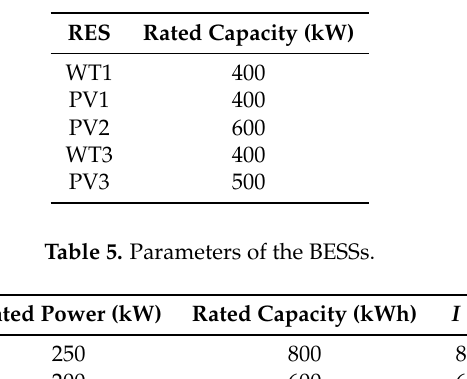
Table 4. Parameters of the RESs.